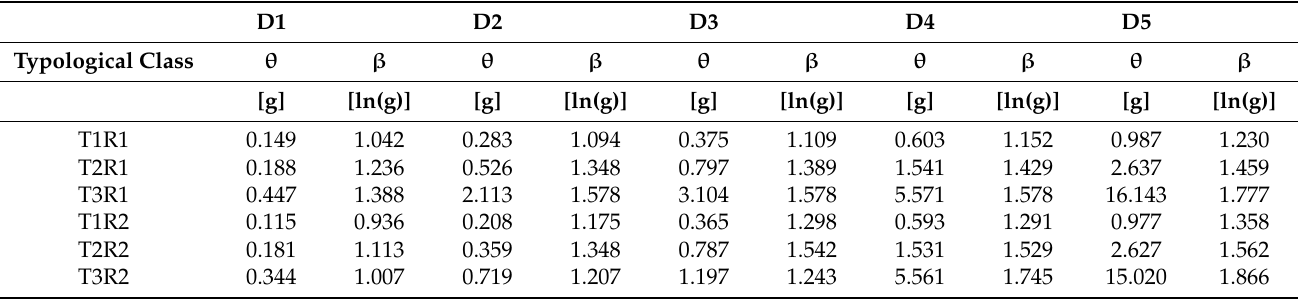
Table 4. Parameters of log-normal fragility curves for the census-based typological classes accounting for construction timespan and state of